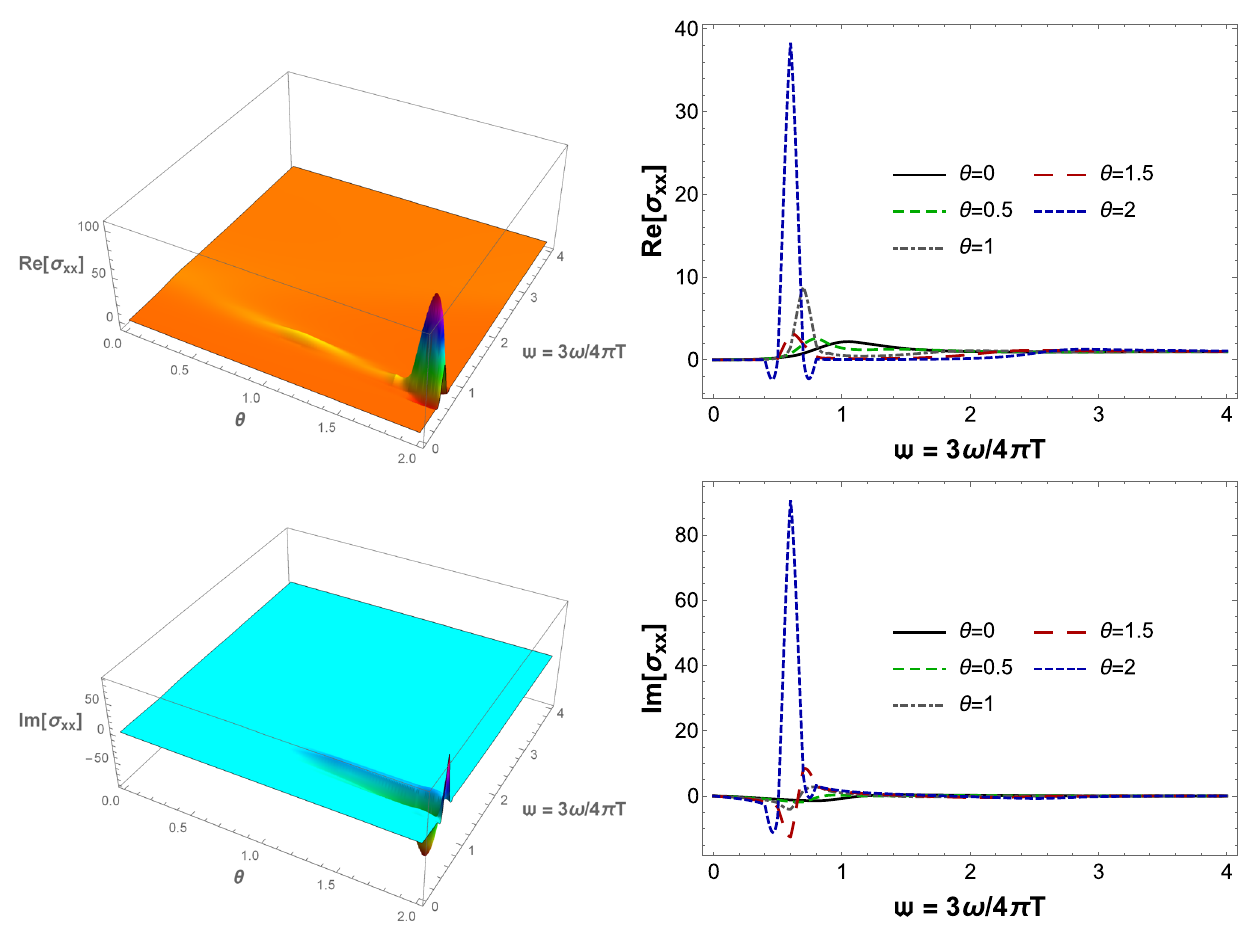
ing the characteristic mass scale (cid:12) of the bulk monopole